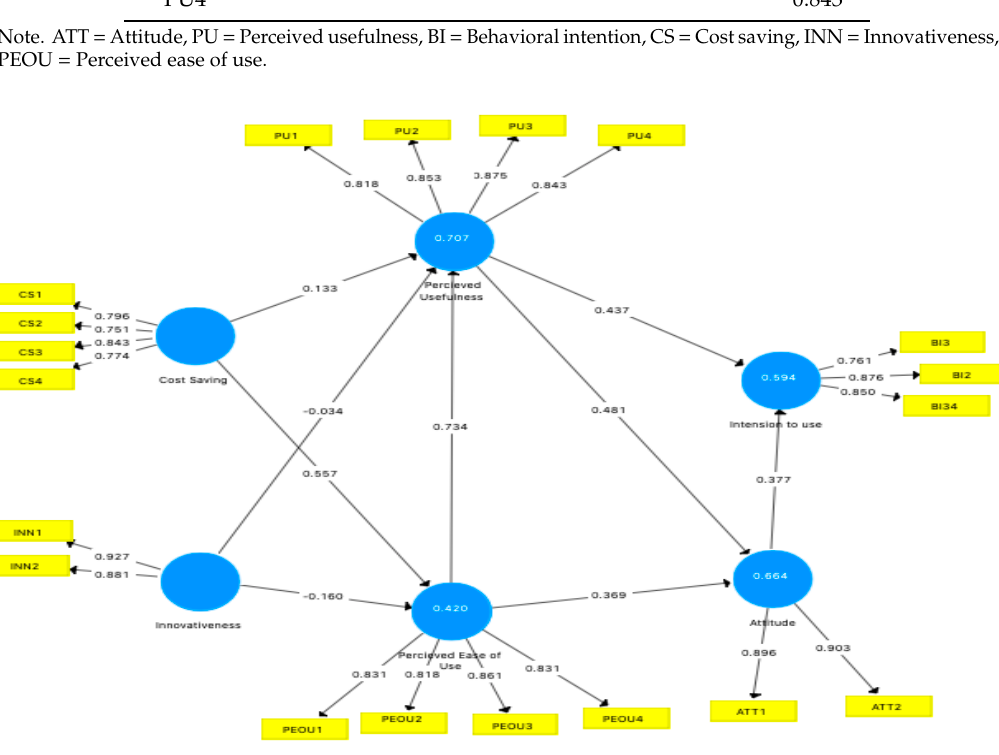
Table 7. Construct reliability.